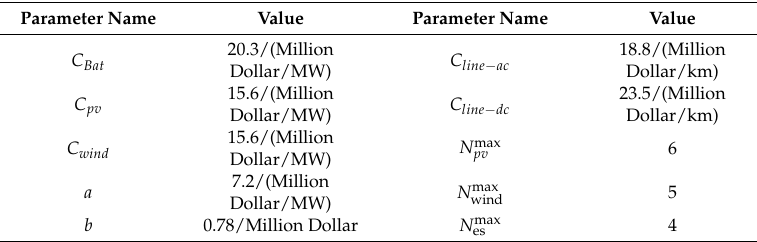
Figure 5. The light intensity and wind speed year data ( a ) annual light intensity curve; ( b ) wind speed curve. Table 1. Technical and economic parameters.